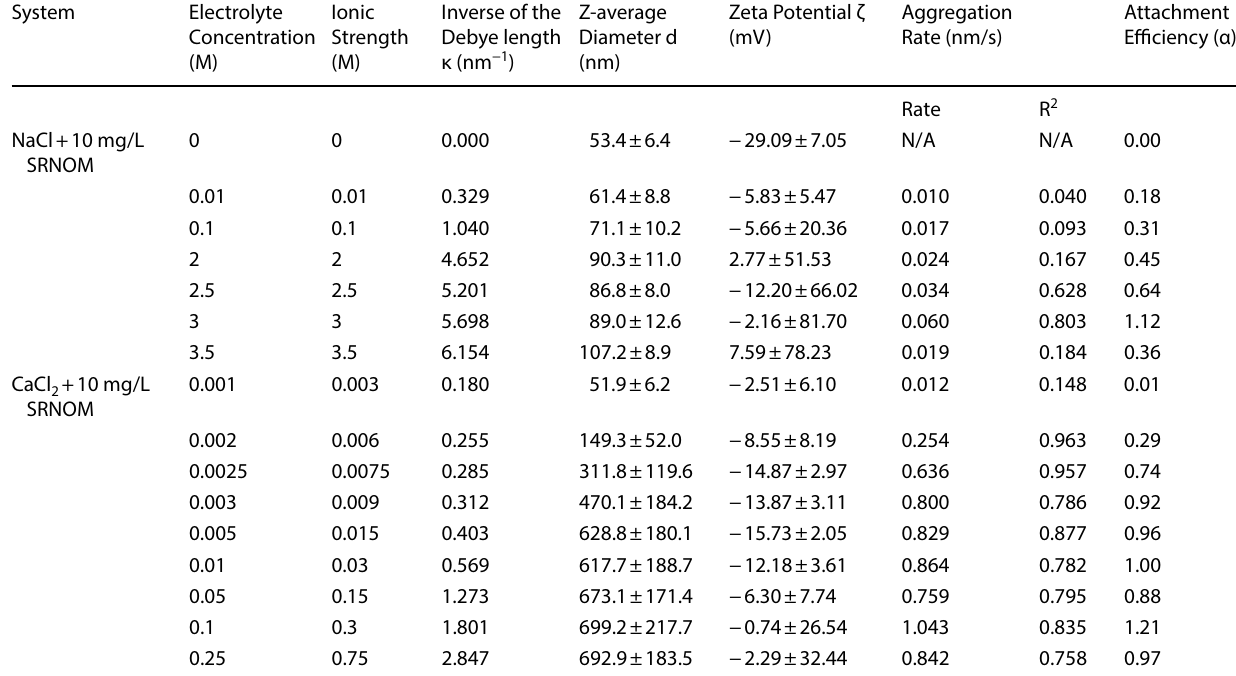
Table 3 Measurements of zeta potentials (ξ potentials) and z-average hydrodynamic diameters (z-avg. HDs), and calculation of Debye length, aggregation rates, and attachment efficiency of QDs suspended in aqueous solutions including diH2O, two types